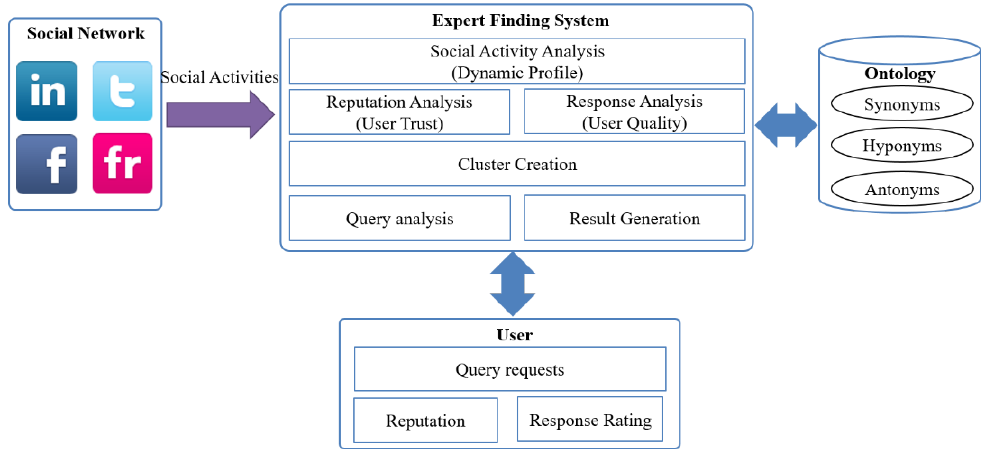
Figure 1. Proposed expert finding system architecture.